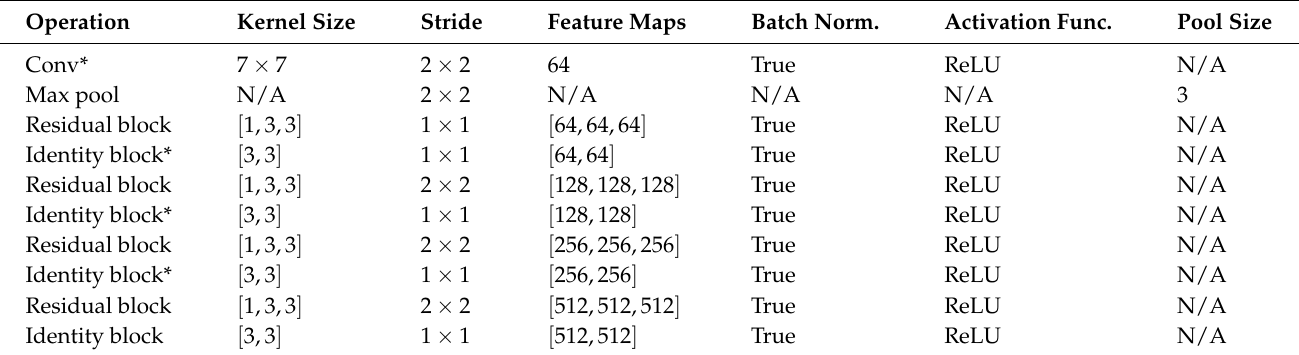
Table 3. Architecture of UNet’s Encoder (ResNet18).